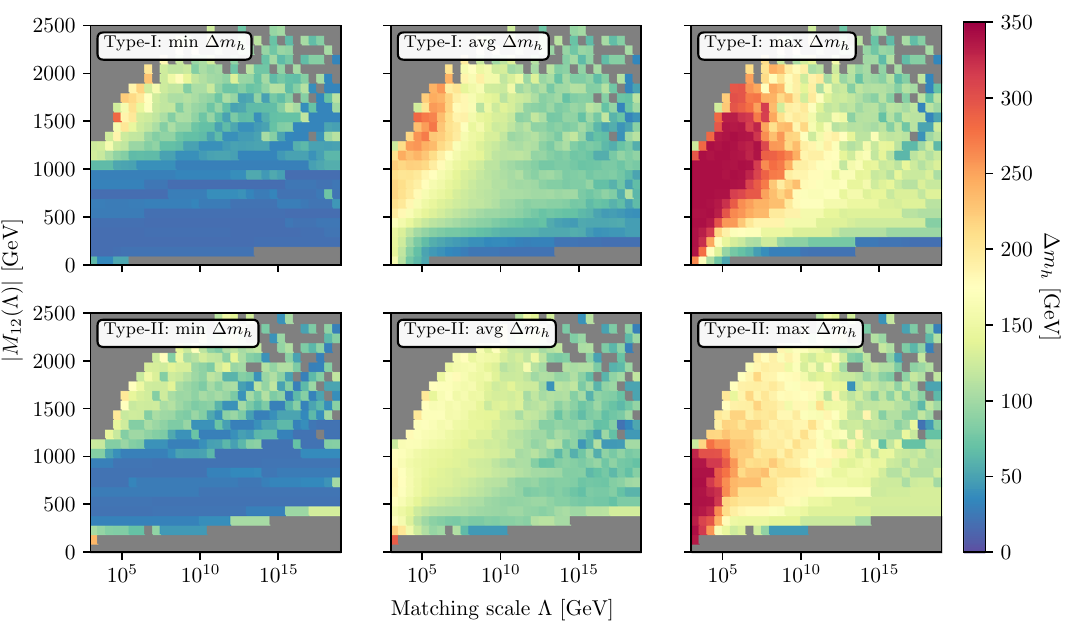
Fig. 6 Size of the loop corrections to m h as a function of the matching scale (cid:10) and M 12 ((cid:10)) . The colours in the plane represent the minimal (left), average (middle) and maximal (right) size of the radiative corrections in the respective bin. We are using type-I Yukawas in the upper row and type-II in the lower